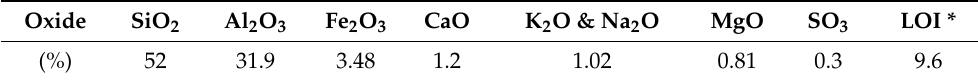
Table 1. Chemical composition of fly